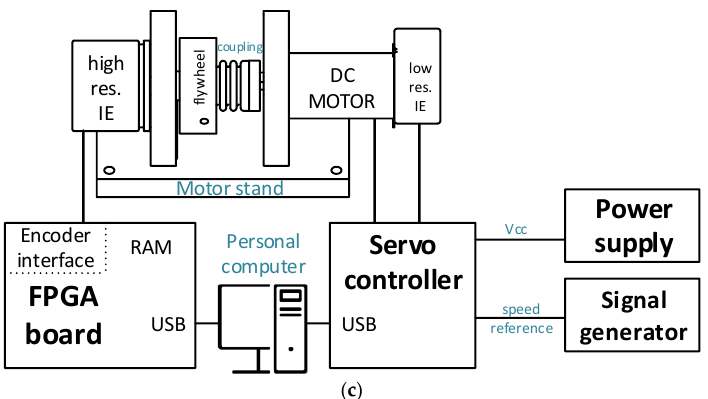
Figure 6. The experimental setup: ( a ) the mechanical drive system with the IE; ( b ) the processing hardware electronics with the FPGA; ( c ) the principal interconnection block sheme.